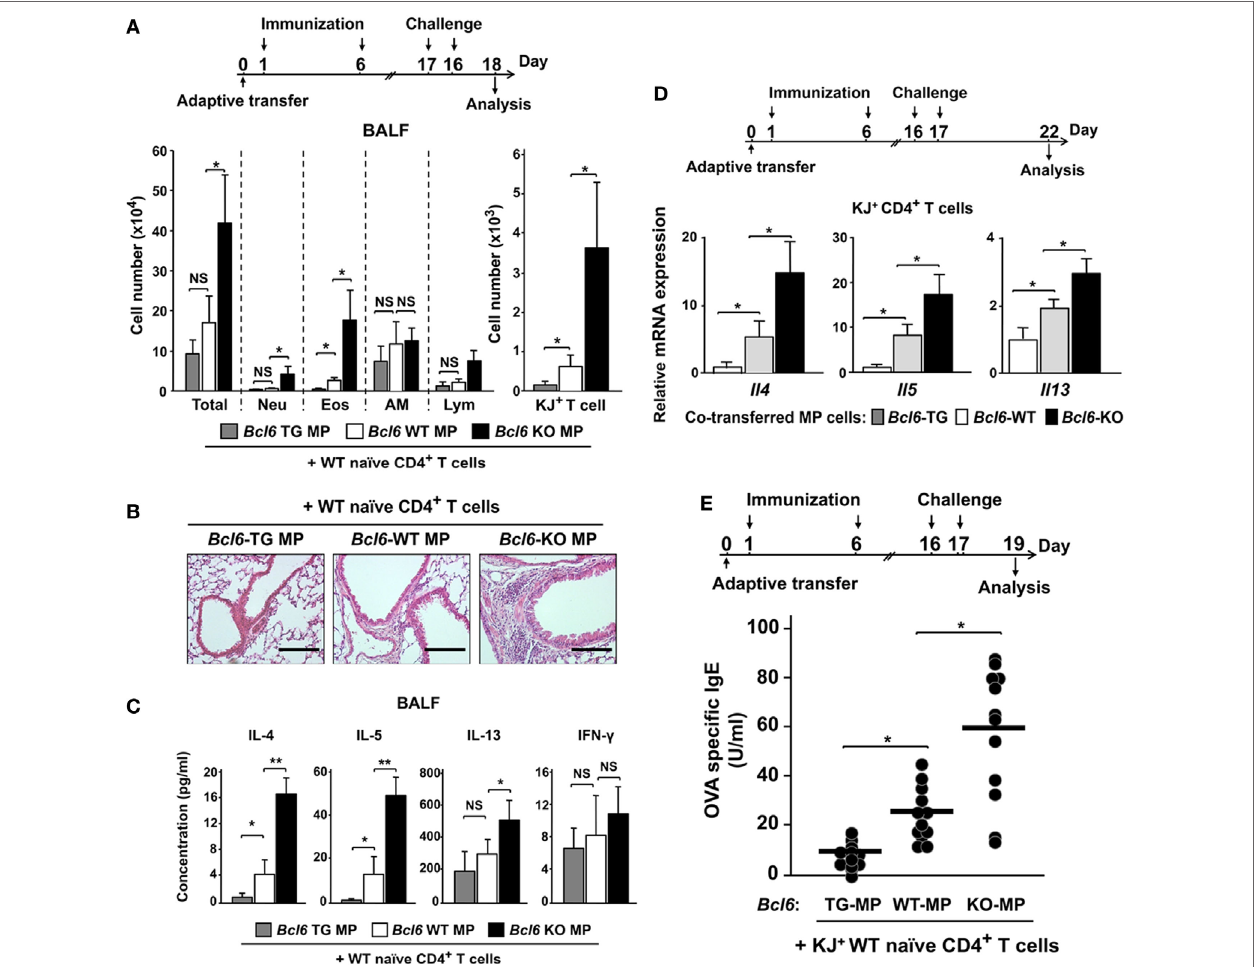
FigUre 7 | Role of Bcl6-mediated MPT cell functions in NAT H 2 differentiation in an allergic murine model. [ (a) top] Mixture of purified KJ1-26 − MPT cells ( Bcl6 -WT or Bcl6 -KO) and KJ1-26 + WT naïve CD4 + T cells were transferred into BALB/c nu/nu mice intravenously (day 0). These mice were immunized with alum-conjugated OVA and then intratracheally challenged with OVA. [ (a) bottom] Absolute cell numbers of Neu, Eos, AM, and Lym in BALF, (B) hematoxylin and eosin-stained, formalin-fixed lung sections (magnification: 200 × ), and (c) T H 2 cytokine levels in the BALF of recipient mice 48 h after the last OVA challenge. (D) Relative Il4 , Il5 , and Il13 expression mRNA in splenic KJ1-26 + T cells restimulated with anti-CD3 monoclonal antibodies 5 days after the last challenge. (e) OVA-specific IgE antibody titers in sera from each recipient of Bcl6 -WT NAT H 2 cells, plus MPT H 2 cells transferred from Bcl6 -TG, Bcl6 -WT, or Bcl6 -KO mice 2 days after the last challenge. All results are representative of four independent experiments with similar outcomes. Data are presented as the mean ± SEM ( n = 5–7) . * P < 0.05, ** P < 0.01, comparison between two groups is indicated. AM, alveolar macrophages; BALF, bronchoalveolar lavage fluid; Bcl6, B-cell lymphoma 6; Eos, eosinophils; KJ + , KJ1-26-positive; KO, knockout; Lym, lymphocytes; MPT cell, memory phenotype CD4 + T cell; MPT H 2 cell, MPT cell-derived T H 2 cell; NAT H 2